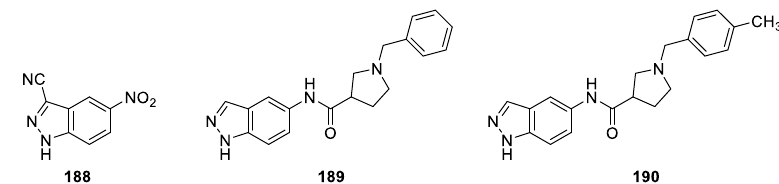
Figure 64. Chemical structures of N-substituted prolinamido indazole derivatives 188 , 189 and 190.